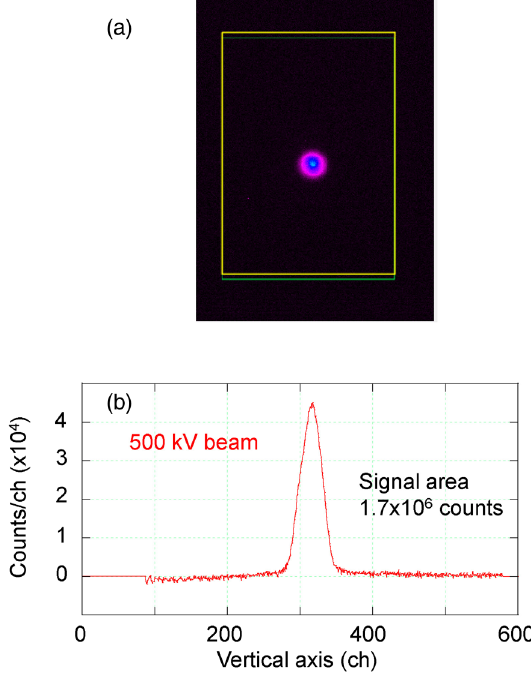
(2013).FIG. 14. (a) Measured profile of 500 keV electron beam to calibrate the signal intensity on the screen. (b) Projection of the vertical axis. The electron beam charge for the screen shot is 0.0692 nC.